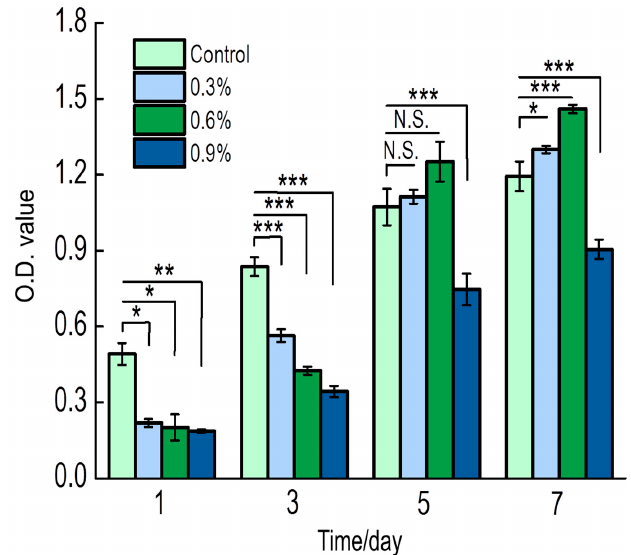
Figure 9. The proliferation of MC3T3-E1 on CS/Gel/nHAp/MWCNTs scaffolds. The cell activity of the CS/Gel/nHAp scaffold was the highest on the 1st and 3rd day, and the cell activity of the MWCNT scaffolds were lower. On the 5th and 7th day, the cell activity of the 0.3% MWCNTs and 0.6% MWCNTs scaffolds were higher than that of the CS/Gel/nHAp scaffold, and the 0.6% MWCNTs scaffold was the highest, but it was lowest for the 0.9% MWCNTs scaffold. Data indicate mean ± SD. The number of living cells was proportional to the OD value. N.S: p > 0.05, * p < 0.05, ** p < 0.01, *** p < 0.001.